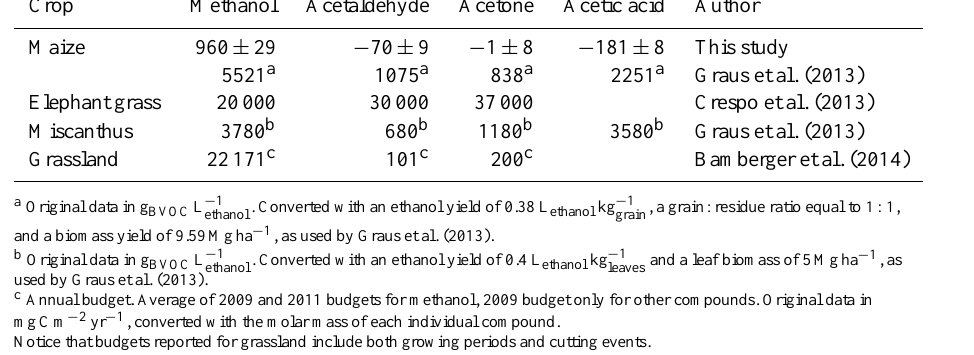
Table 5. BVOC budget estimated for maize at LTO and on diverse crops over a whole growing season. [g BVOC ha − 1 ] Crop Methanol Acetaldehyde Acetone Acetic acid Maize 960 ± 29 − 70 ± 9 − 1 ± 8 − 181 ± 8 This study 5521 a 1075 a 838 a 2251 a Graus et al. (2013) Elephant grass 20000 30000 37000 Crespo et al. (2013) Graus et al.